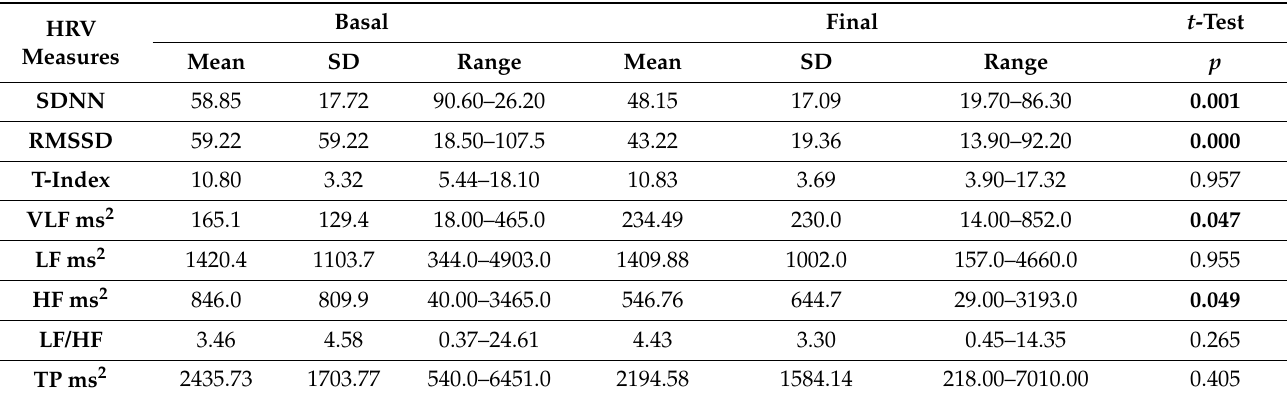
Table 2. Heart rate variability (HRV) parameters (mean, SD, and range) for basal and final time of sampling and t -test results for paired data between basal and final time